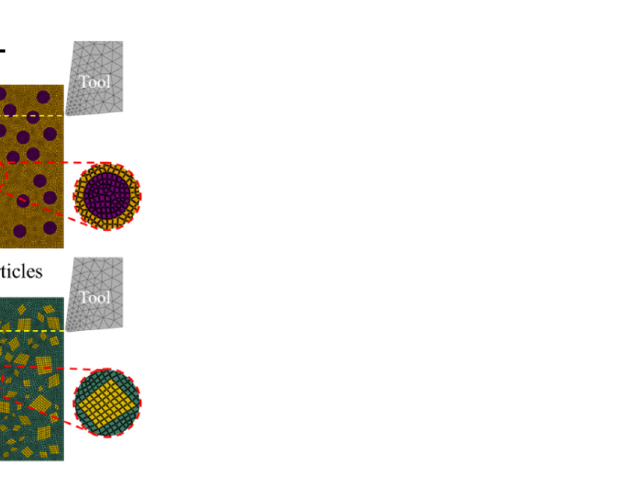
Figure 1. Microstructure of the SiC p/Al composite.